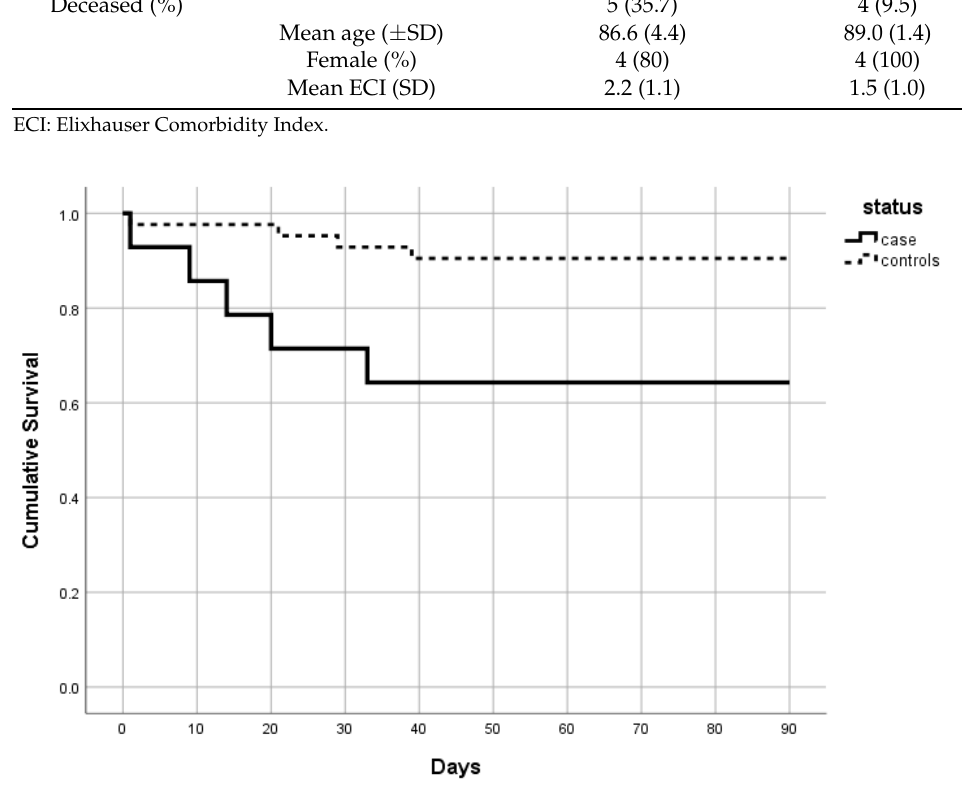
Figure 2. Ninety-day survival curve of cases and